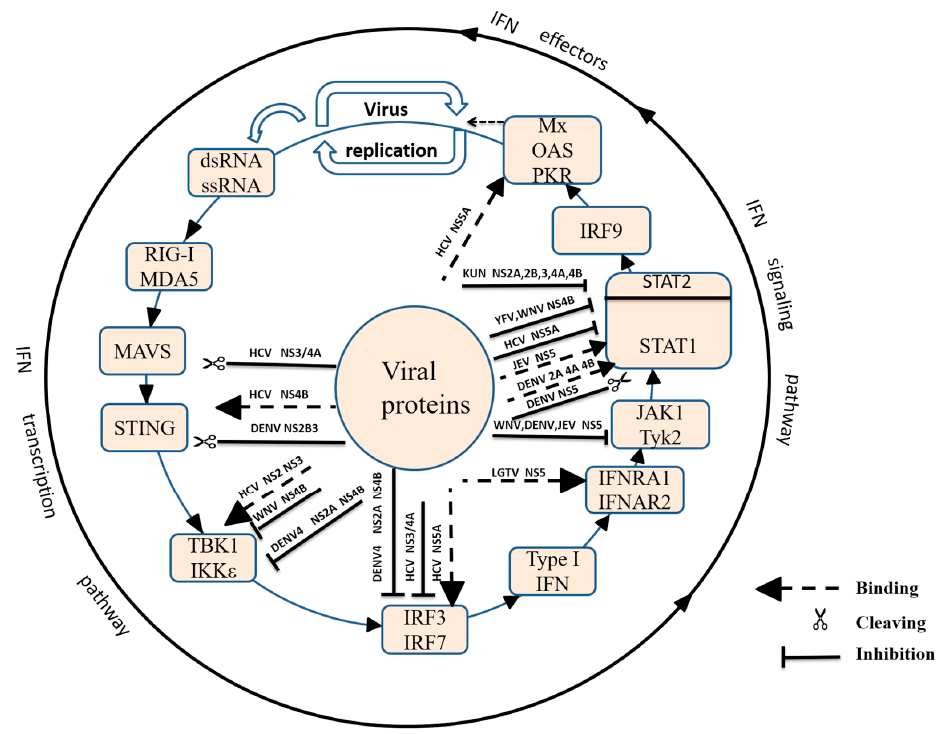
Figure 2. Suppression of type I IFN production by Flaviviridae viruses. Toll-Like receptors (TLRs) and retinoic acid-inducible gene I (RIG-I) receptors are activated by the virus; host antiviral responses are then activated, leading to the production of type I IFN. The binding of type I IFN to its cognate IFNARs activates the Janus kinase (JAK)-signal transducer and activator of transcription factor (STAT) signalling pathway. Secreted type I IFNs bind their cognate heterodimeric receptors (IFNAR1 and IFNAR2) and induce Tyk2 and Jak1 kinase activation, leading to the formation of the ISGF3 transcription factor complex. The complex translocates into the nucleus and induces the transcription of antiviral IFN-stimulated genes (ISGs). Flaviviridae have developed multiple strategies to escape or counteract host immune responses, including cleaving mitochondrial antiviral signaling (MAVS) by hepatitis C virus (HCV) NS3/4A; competing with MAVS for binding to stimulator of IFN genes ( STING ) to affect RIG-I-like receptors (RLRs) signalling transduction by HCV NS4B; cleaving STING by dengue virus (DENV) NS2B3; interacting with TANK-binding Kinase (TBK1) by HCV NS2 and NS3; inhibiting TBK1 phosphorylation by West Nile virus (WNV) NS4B and DENV4 NS2A and NS4B; inhibiting interferon regulatory factor-3 (IRF3) phosphorylation by DENV4 NS2A and NS4B and HCV NS3/4A; inhibiting interferon regulatory factor-7 (IRF7) activation by interacting with IRF7; interacting with IFNAR1 by Langat virus (LGTV) NS5; reducing Tyk2 phosphorylation by Japanese encephalitis virus (JEV), DENV and JEV NS5; interacting with STAT1 by DENV NS2A, NS4A and NS4B and JEV NS5; cleaving STAT1 by DENV NS5; inhibiting STAT1 phosphorylation by HCV NS5A, yellow fever virus (YFV) and WNV NS4B; inhibiting STAT2 phosphorylation by Kunjin virus (KUNV) NS2A, NS2B, NS3, NS4A and NS4B; and suppressing double-stranded RNA-activated protein kinase (PKR) and 2’-5’ OAS function by HCV NS5A.